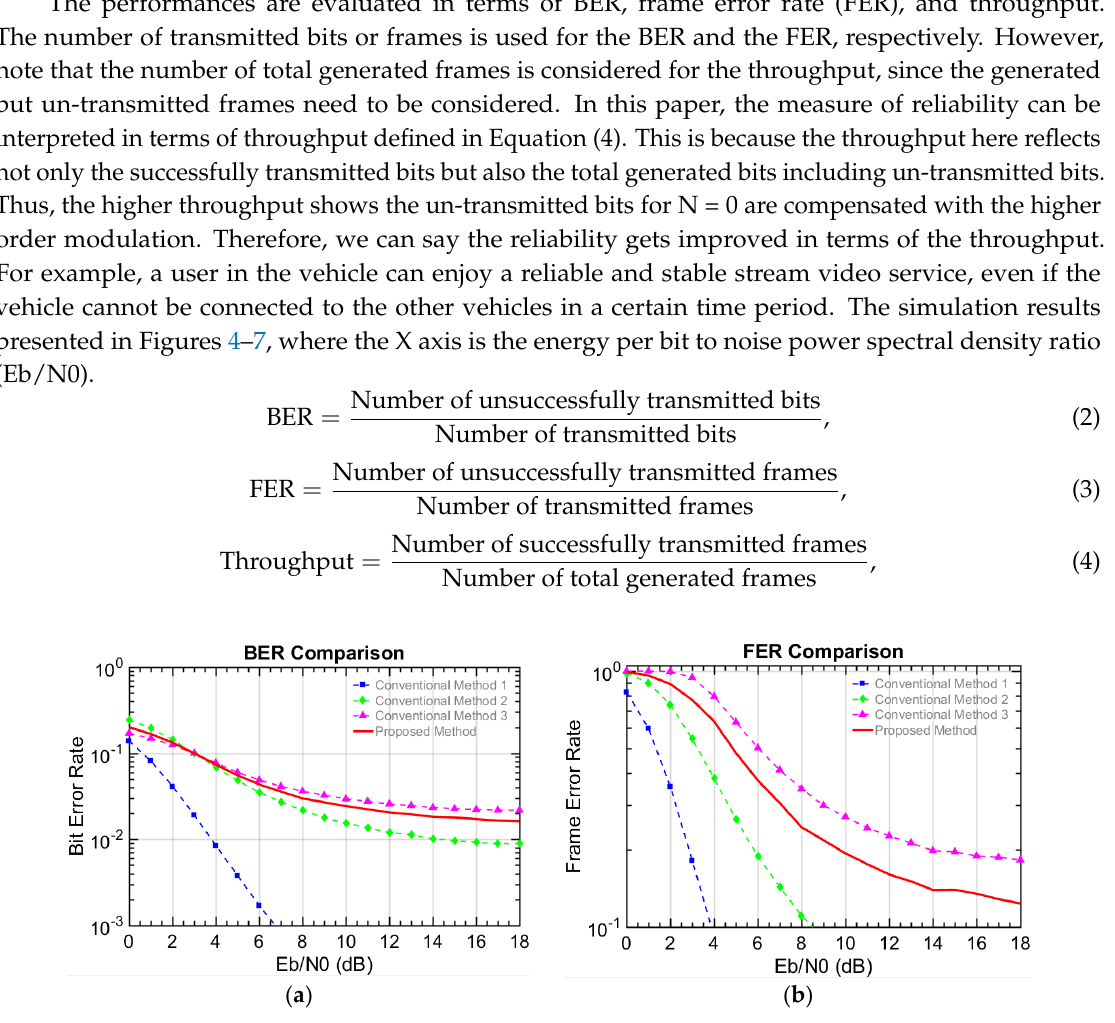
Figure 4. Error rate performance of V2V scenario I in a Rician fading channel a with a constant K-factor value (10 dB): the ( a ) BER performance and the ( b ) FER performance.